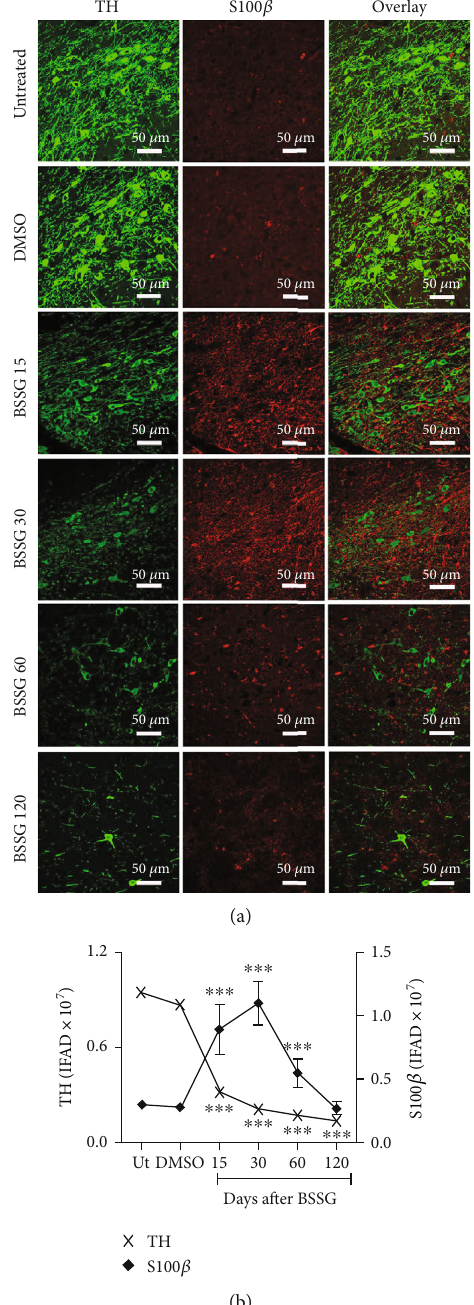
Figure 5: Time course of the reactive astrocyte induction marker S100 β after a BSSG injection in the SNpc. (a) Representative micrographs of double immuno fl uorescence of TH and S100 β in untreated (Ut) control rats and rats at di ff erent times (shown at the left side of micrographs) after BSSG injection. (b) IFAD quanti fi cation for TH and S100 β during the experimental time course. The values are the mean ± SD from four anatomical levels. n = 3 independent rats in each time of each experimental condition. Two-way ANOVA and post hoc Bonferroni tests were applied for statistical analysis. ( ∗∗∗ ) indicates a P < 0 : 001 compared with the DMSO mock and Ut groups of the respective